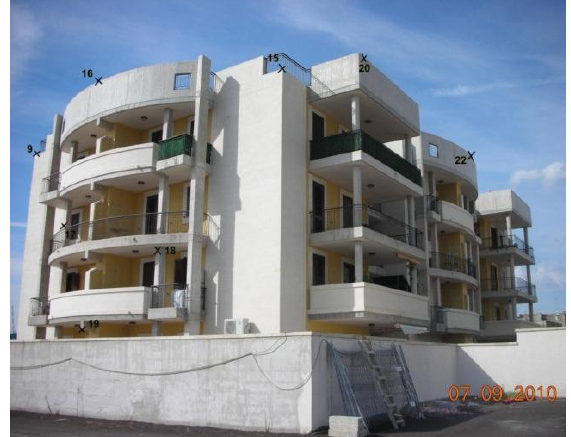
Figure 6. Scheme of survey